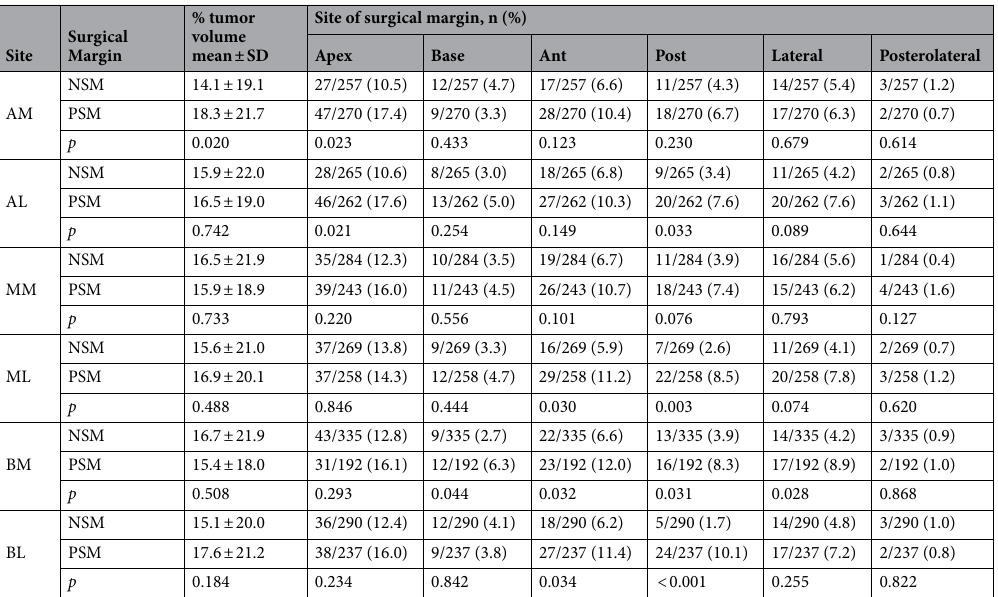
Table 3. Site-specific surgical margin status and tumor volume according to the site of positive biopsy for prostate cancer. AM apical medial, AL apical lateral, MM middle medial, ML middle lateral, BM basal medial, BL basal lateral, NSM negative surgical margin, PSM positive surgical